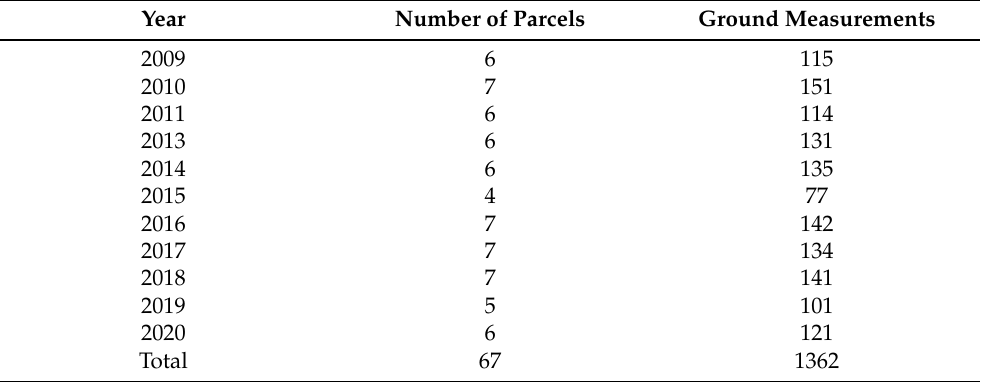
Table 2. Ground reference data: parcels and measurements per year. This dataset is subdivided into testing and training data (see Section